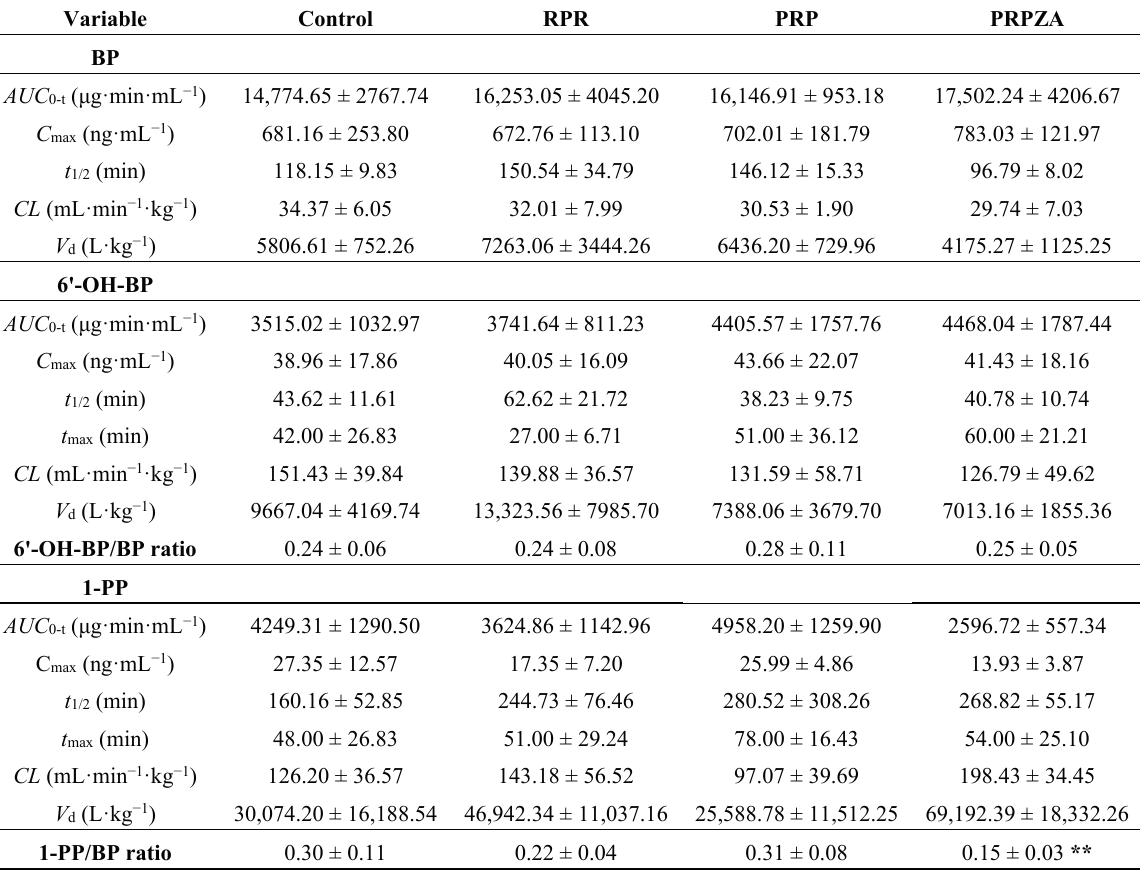
Table 1. Pharmacokinetic parameters of buspirone (BP), 1-(2-pyrimidinyl) piperazine (1-PP) and 6'-hydroxybuspirone (6'-OH-BP) in rats after intravenous injection of 0.5 mg·kg − 1 BP·HCl. Prior to intravenous injection of BP·HCl, the rats were orally pretreated with RPR, PRP, PRPZA (0.9 g·kg − 1 ·day − 1 ), or saline once daily for 7 days. The data presented in this table indicate mean ± SD ( n =